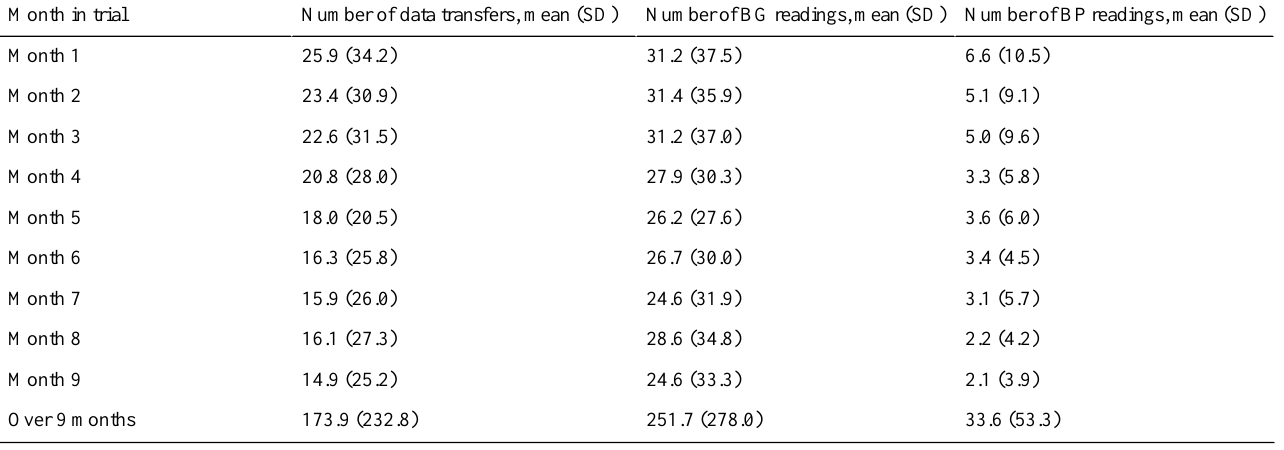
Table 2. Number of MTH data transfers and clinical readings transmitted during the 9-month study.